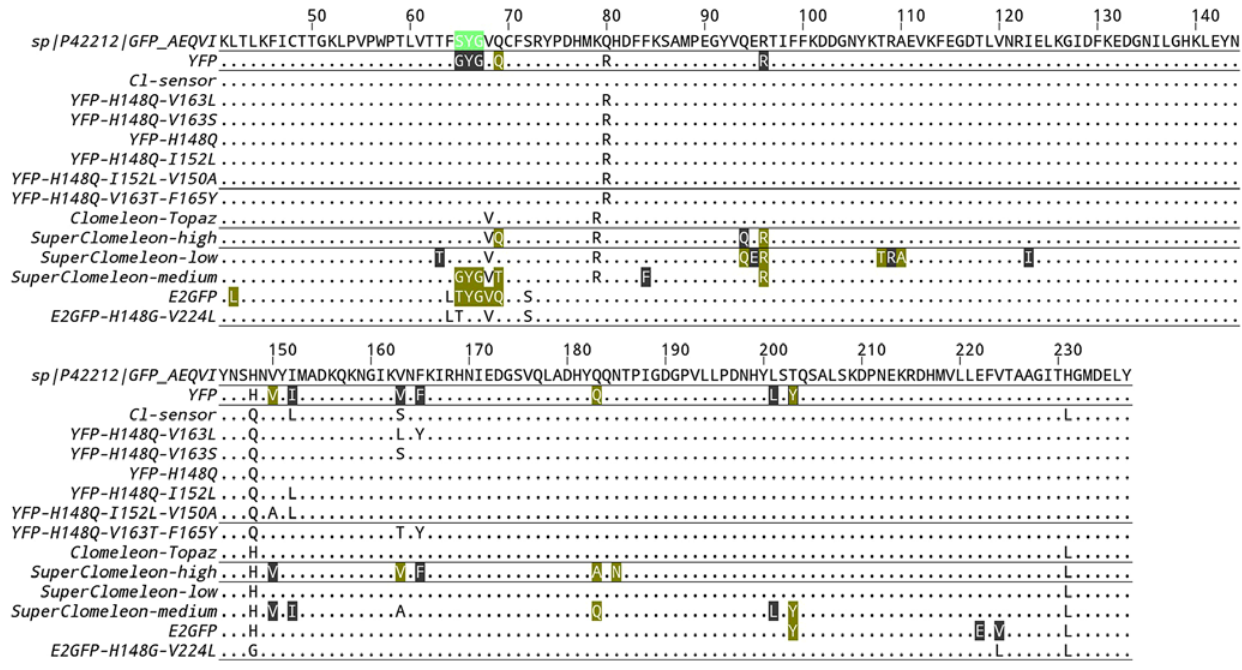
highlight indicates a residue that forms either van-der-Walls or hydrogen bonds to the chloride ion. Gray highlight indicates a residue that is located within a radius of 5 Å around the chloride ion without forming any specific type of